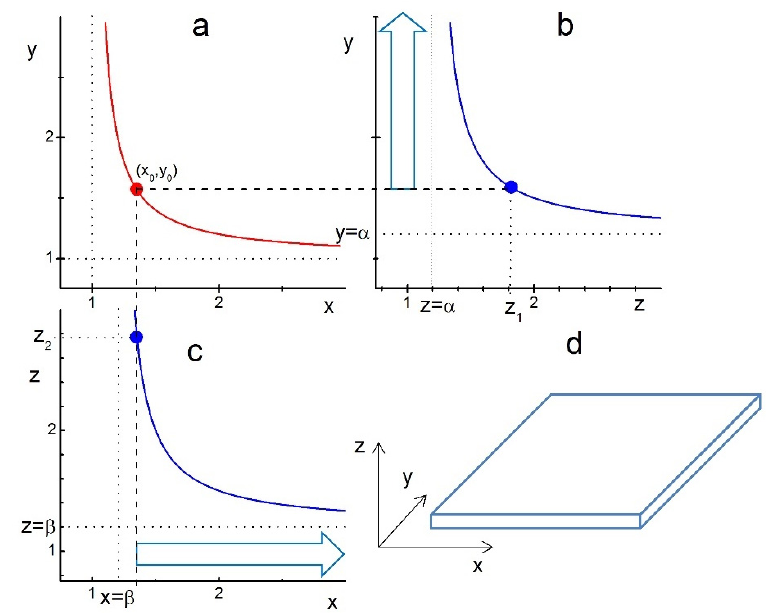
Figure 1. Illustration of ligand-assisted growth of a nanoplatelet from an ideal cuboid crystal and anisotropy of the LCN sizes L yz = α L xy and L xz = β L xy . The curves represent the boundary functions given by Equation (10): ( a ) y ( x ) , ( b ) y ( z ) , and ( c ) z ( x ) with parameters C = 0.2, α = β = 1.2. The points ( x 0 , y 0 ) , ( z 1 , y 0 ) and ( x 0 , z 2 ) on the corresponding curves indicate the formation of compact layers of ligands on the xy , zy and xz facets, respectively. The compact layer of ligands is supposed to be formed first at the point ( x 0 , y 0 ) . Therefore, the z -edge of the crystal at this point has to be significantly lower than z max = min { z 1 , z 2 } . ( b ) The vertical arrow indicates the growth of the crystal’s y -edge for z ≤ α . ( c ) The horizontal arrow indicates the growth of the crystal’s x -edge for z ≤ β . ( d ) Nanoplatelet-like shape of the crystal growing with z ≤ α = β after its xy -facet is covered with a compact layer of ligands.